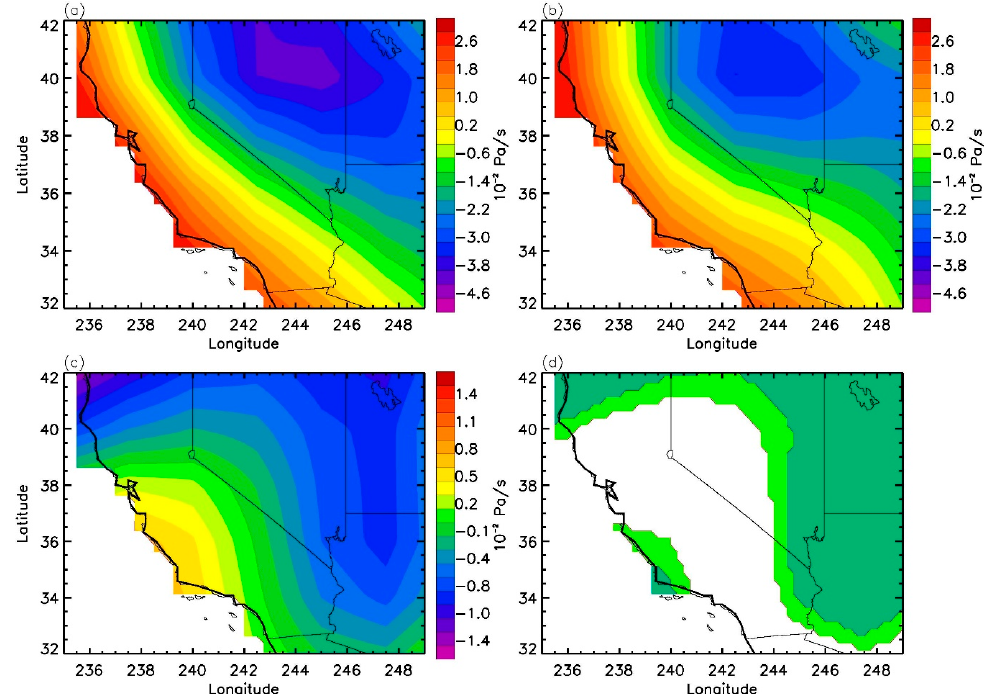
Figure 3. ( a ) The mean value of 500 hPa vertical pressure velocity, from NCEP2, in dry years (JJAS of 2003, 2007, and 2010); ( b ) the mean value of 500 hPa vertical pressure velocity in wet years (JJAS of 2006, 2008, 2011, and 2012); ( c ) 500 hPa vertical pressure velocity differences between the dry and wet years; and ( d ) vertical pressure velocity differences within 5% significance level and 1% significance level are highlighted in light green and dark green. Units for Vertical pressure velocity are 10 − 2 Pa/s in ( a – c ).